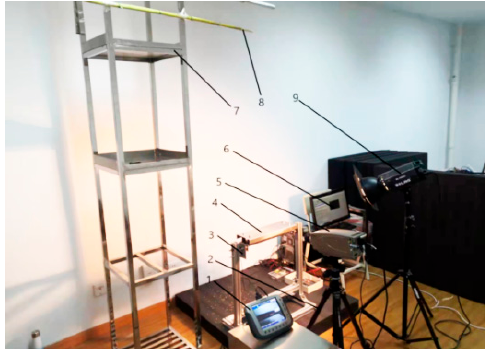
Figure 1. High-speed photographic collection of grain collision information. 1—High-speed camera display, 2—support tripod, 3—sensor mounting bracket, 4—grain loss sensor, 5—high-speed camera, 6—signal acquisition program, 7—height-fixing frame, 8—grain falling height position, 9—fill-in light.